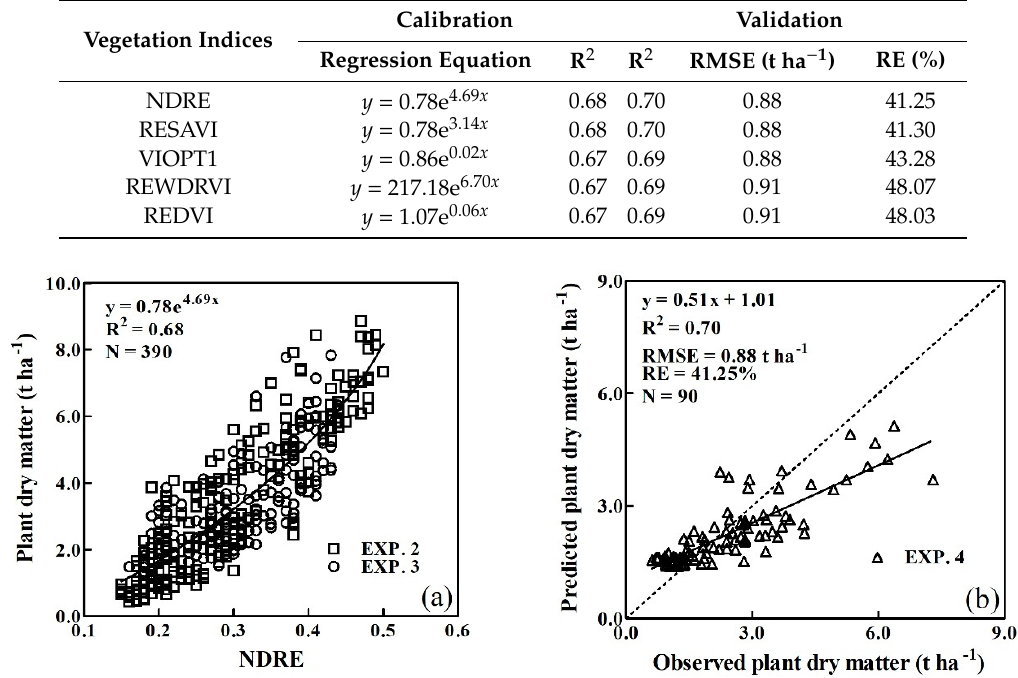
Table 3. Calibration and validation results for the relationship between plant dry matter (PDM) and the top 5 vegetation indices across all growth stages.